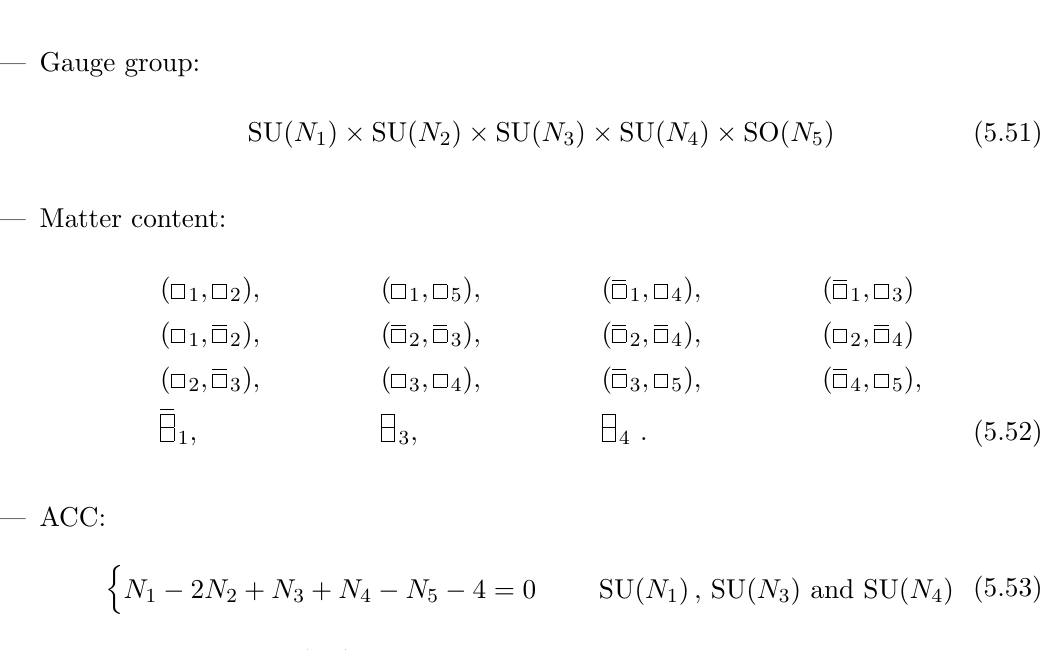
(cid:2) Z dimer with orientifold 3 3